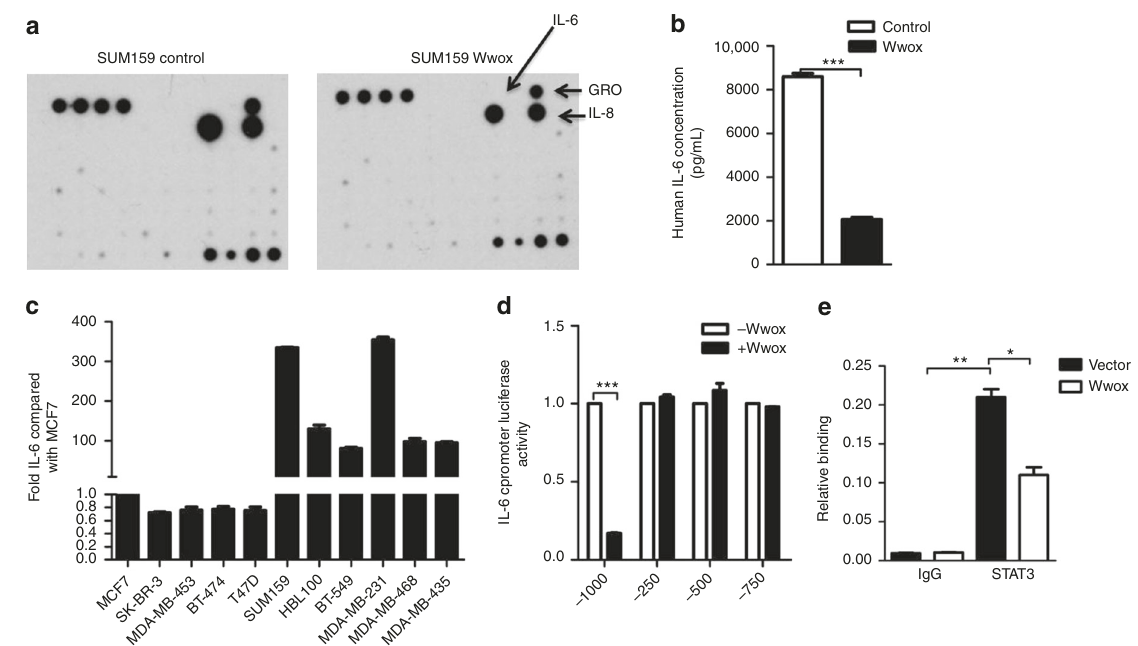
Fig. 5 Wwox inhibits IL-6 induction. a Cytokine array analysis of conditioned medium (CM) from SUM159 cell culture. Equal numbers of SUM159 cells transfected with control empty vector (159 control) or with Wwox overexpression construct (159 Wwox) were seeded on culture plates and incubated in DMEM supplemented with 10% FBS for 24 h at 37 °C to allow cell attachment; culture medium was then switched to DMEM without serum. After incubation for 48 h, CM was collected and centrifuged at 2000 × g for 10 min at 4 °C to remove cell debris. The resulting supernatant was used for the experiment. b ELISA quanti fi cation of IL-6 production in the same CMs analyzed by the cytokine array in a . c IL-6 production by various luminal breast cancer (BC) cells and basal-like BC cells analyzed by ELISA compared with IL-6 production by MCF-7 cells. d Wild-type ( − 1000 to + 1 bp with respect to the transcription start site) and truncated IL-6 promoter constructs were co-transfected with a vector encoding Wwox, and the luciferase activity was determined. e 293T cells were transfected with Wwox plasmids, and cultures were analyzed for STAT3 binding to the IL-6 promoter. Data represent the mean ± SD ( n = 3) from three independent experiments; * p < 0.05, ** p < 0.01, *** p < 0.001, Student ’ s t